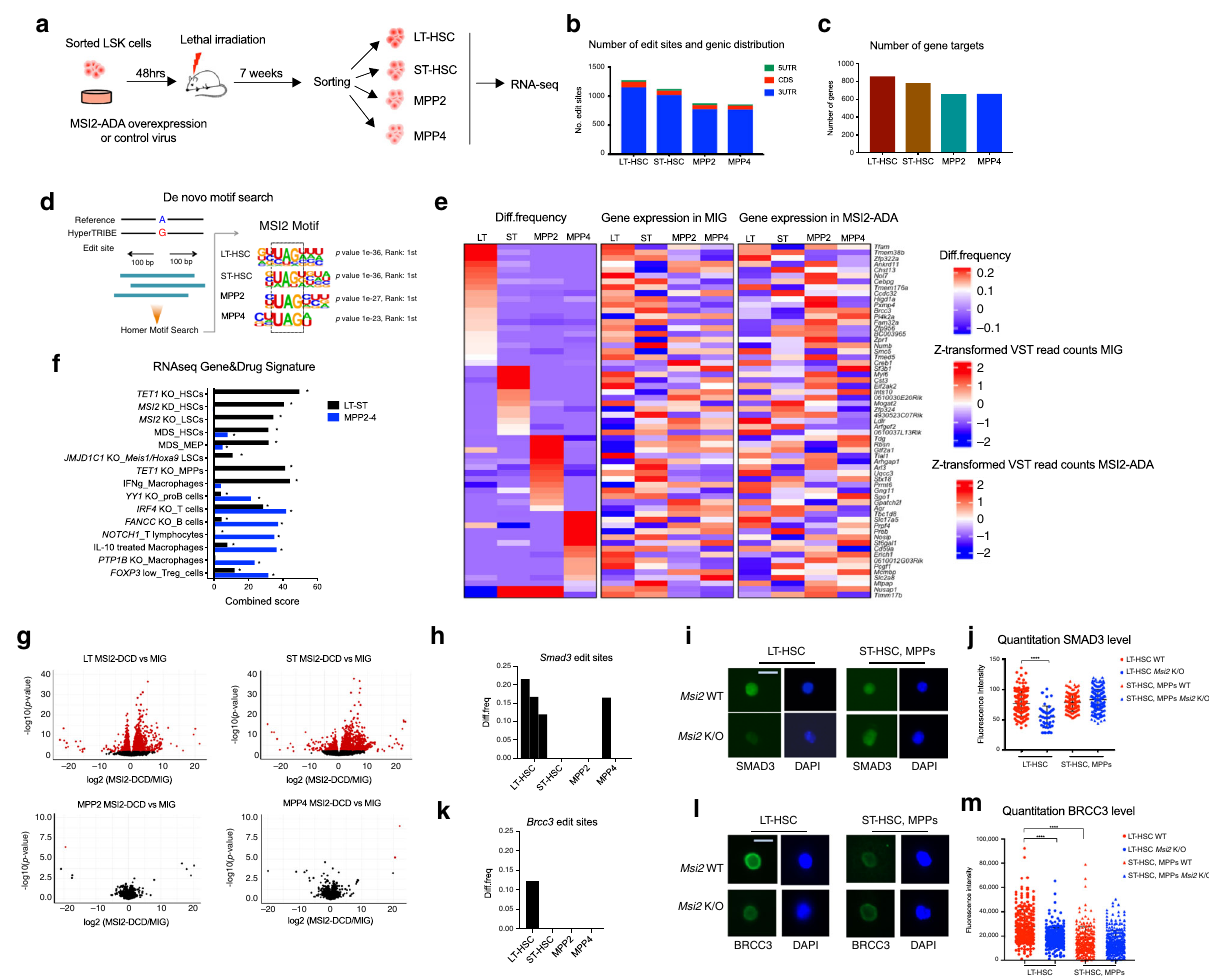
Fig. 2 Cell context MSI2 binding during hematopoietic stem cell differentiation. a Schematic illustration of MSI2-HyperTRIBE in HSPCs in vivo. n = 2 independent experiments. b Number of MSI2-HyperTRIBE signi fi cant edit sites and their genic distribution in four compartments of HSPCs. c Number of target genes with sites (described in b ) in HSPCs. d De novo motif search showing enrichment of MSI2 motif in all four populations of HSPCs. e Clustering of diff.frequency for target genes across cell types (left panel). Only genes more signi fi cantly edited (beta-binomial test) in one cell type versus all others are plotted. Relative gene expression of each target, in same row order as diff.frequency heatmap, in control cells MIG (middle panel) and for MSI2-ADA overexpressing cells (right panel). LT:LT-HSC; ST:ST-HSC. f RNA-seq Gene and Drug Signature analysis for MSI2 targets in LT and ST HSCs (LT-unique, ST-unique and Shared LT-ST) compared with targets in MPPs (MPP2-unique, MPP4 unique and Shared MPP2-MPP4). Asterisks indicate FDR < 0.05. g Differential expression (DEseq2) analysis of MSI2 overexpression in four HSPCs populations. Red dots represent genes with signi fi cant differential expression in MSI2-DCD versus MIG control. h Editing occurs on Smad3 mRNAs at three sites in LT-HSC, 0 sites in ST-HSC and MPP2 and one site in MPP4. Each bar represents one site. i Representative images of immuno fl uorescence analysis (IF) showing SMAD3 signal in LT versus ST, MPPs. Scale bar 5 μ m. j Quantitation of SMAD3 IF signal from i . n = 125; 45; 130, and 203 cells for LT Msi2 WT; KO; ST, MPPs Msi2 WT and KO, respectively. Data as mean ± SEM. Unpaired Student t test, **** p < 0.0001. k Editing occurs on Brcc3 mRNAs only in LT-HSC and not in other populations. Each bar represents one site. l Representative IF images showing BRCC3 signal in LT versus ST and MPPs. Scale bar 5 μ m. m Quantitation of BRCC3 IF signal from l in Msi2 WT and Msi 2 K/O. n = 258; 263; 216 and 295 cells for LT Msi2 WT; KO; ST, MPPs Msi2 WT and KO, respectively. Data as mean ± SEM. Unpaired Student t test, **** p <